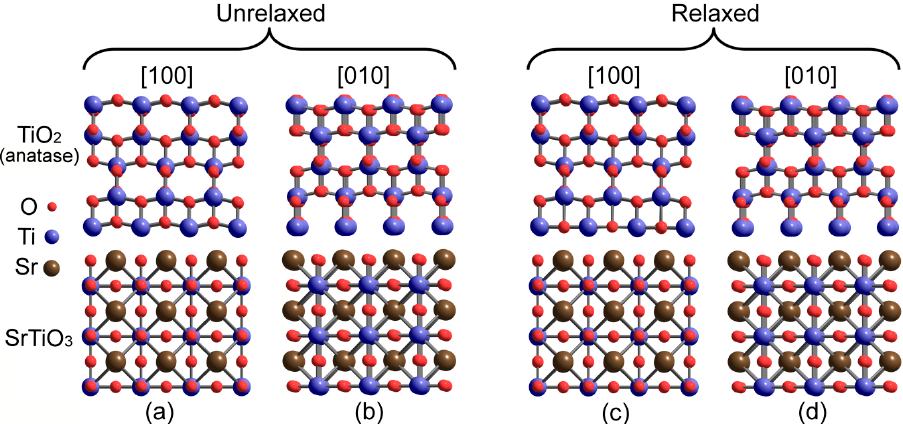
Figure 11. Structures of ( a , b ) unrelaxed and ( c , d ) relaxed interfaces between the SrO-terminated SrTiO 3 and the Ti-terminated TiO 2 according to [145]. Interface titanium atoms of TiO 2 are located above hollow sites of SrTiO 3 surface. The views are along ( a , c ) the [100] and ( b , d ) the [010] directions.